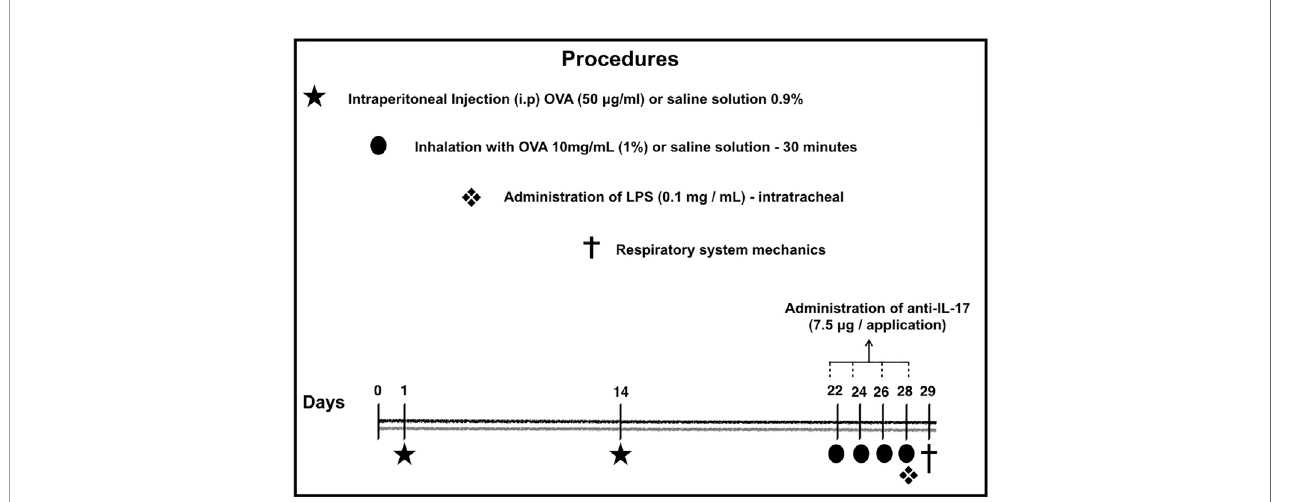
FIGURE 1 | Timeline of the sensitization protocol. On days 1 and 14, the BALB/c mice received a solution of OVA intraperitoneally (i.p.). On days 22, 24, 26 and 28, the animals were submitted to inhalation for 30 min at 1% concentration. The control group received a saline solution i.p. and was exposed to 0.9% saline aerosol for 30 min as the inhalation challenge. Anti-IL-17 neutralizing antibody was administered i.p. 1 h prior to the intratracheal instillation of LPS. Twenty-four hours after the fi nal antigen challenge, on day 29, the animals received LPS intratracheally. On the 29 th day, the mechanics of the respiratory system and bronchoalveolar lavage (Barlow et al., 2011; Starkhammar et al., 2012; Camargo et al.,